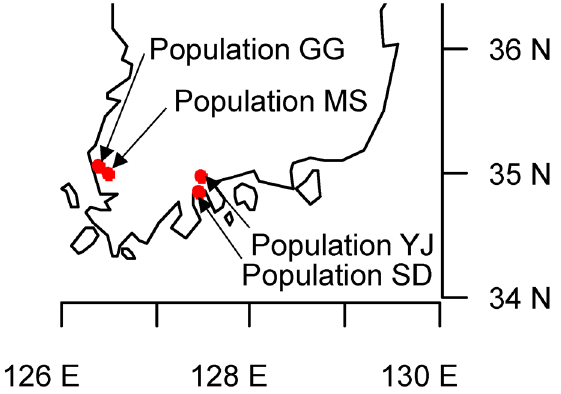
Figure 1. Sampling sites of Lactuca serriola . Seeds were collected from two distant geographical regions (Muan- gun and Suncheon-si) with two sampling sites each. The map was generated using maps package in R (Version 4.0.1, https:// www. cran.r- proje ct. org/ web/ packa ges/ maps/ maps.